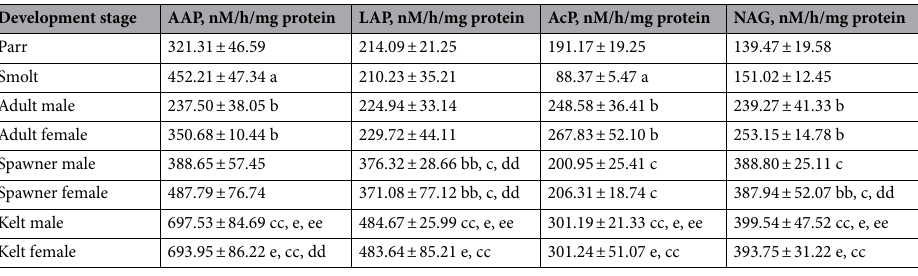
Table 2. Alanyl aminopeptidase, leucyl aminopeptidase, acid phosphatase, and β-N-acetylglucosaminidase (nM/h/mg protein) activities in the muscle tissue of the sea trout ( Salmo trutta m. trutta L.) during different